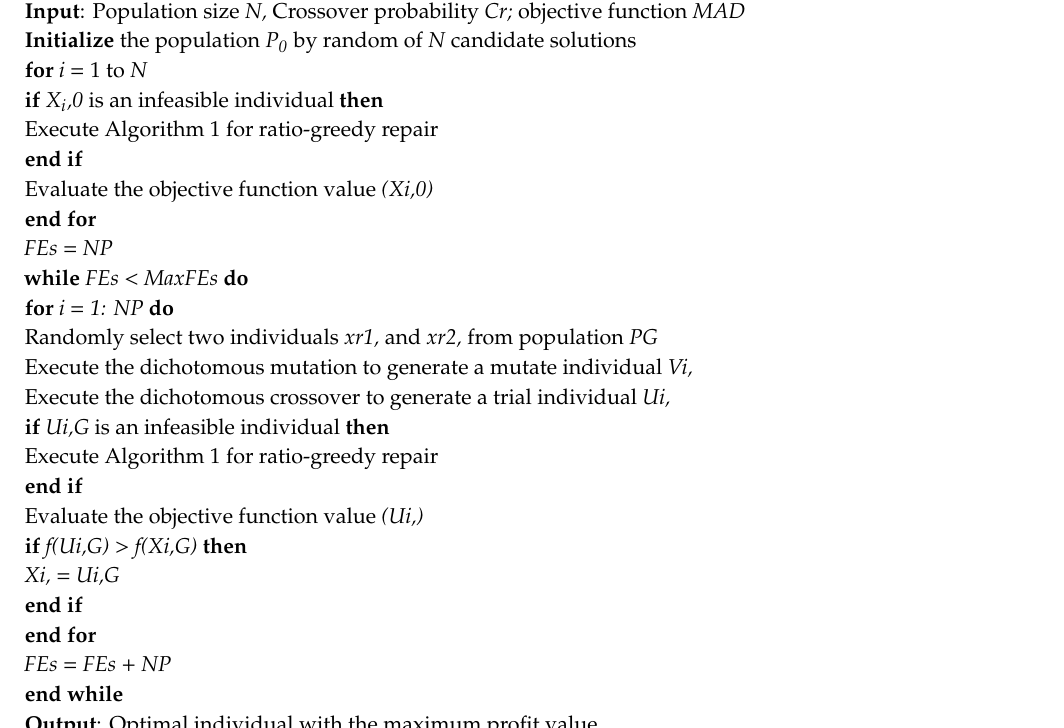
Algorithm 1 . Dichotomous DE logical